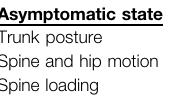
TABLE 2 | Testing procedure and outcome measurements.